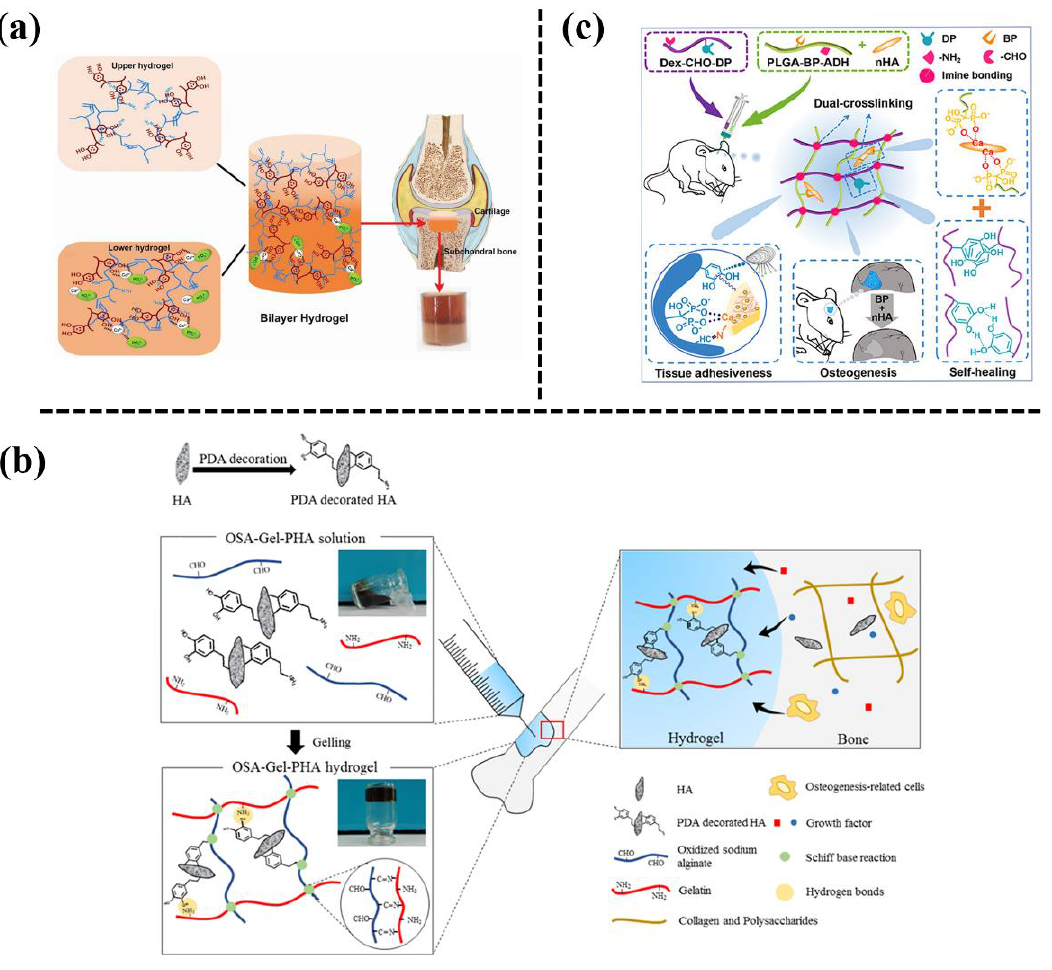
Figure 1. ( a ) Illustrative diagram for the preparation of a mussel-inspired GelMA hydrogel with in situ mineralization of nano-hydroxyapatite to repair osteochondral defects [48]. ( b ) Incorporation of PDA-modified hydroxyapatite nanoparticles (PHA NPs) into an oxidized sodium alginate/gelatin hybrid hydrogel for bone regeneration [49]. ( c ) Preparation of mussel-inspired bisphosphonated injectable nanocomposite hydrogels with adhesive, self-healing, and osteogenic properties [50].